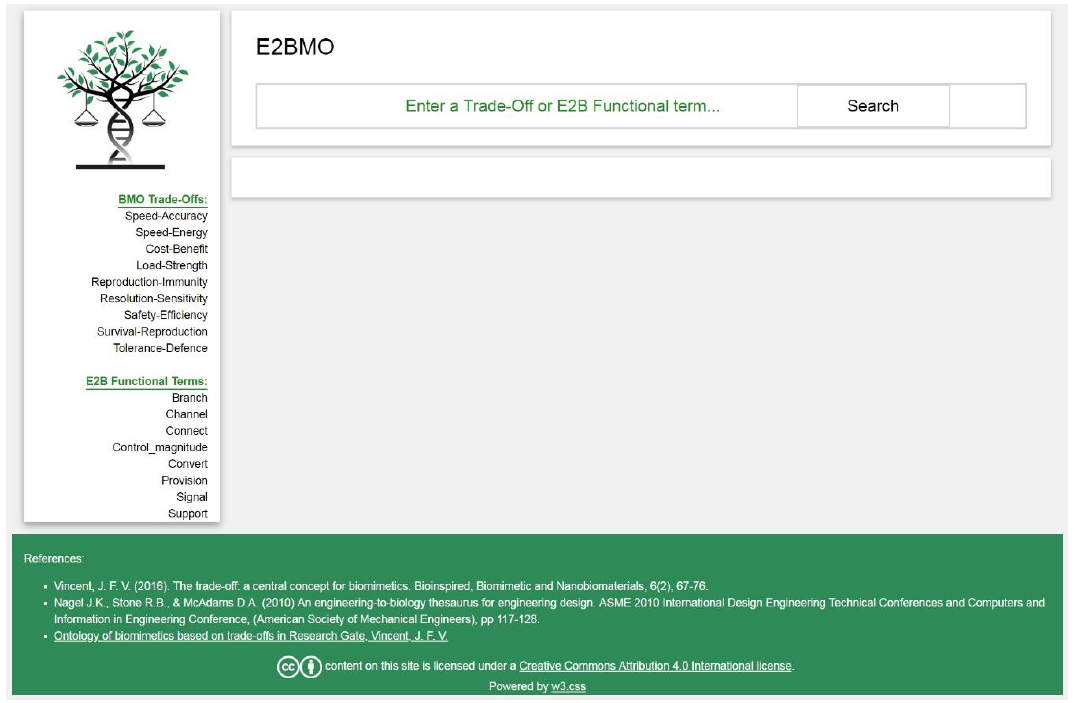
Figure 5. Homepage of E2BMO Website.